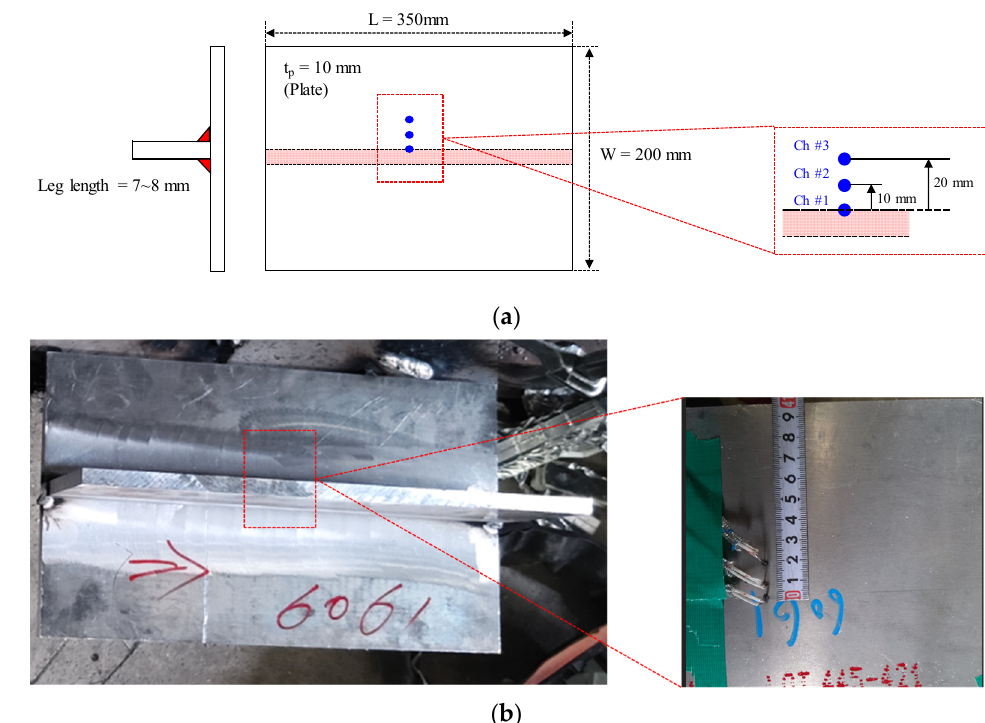
Figure 10. Attachment location of thermocouple (K-type): ( a ) Schematic figure; ( b ) Attached thermocouple of real specimen.